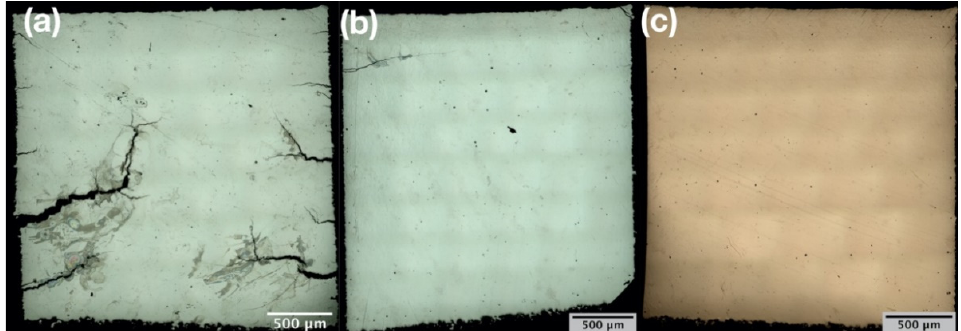
Figure 3. Typical OM images of the polished samples fabricated from the Ti 2 AlNb-CYB powder showing ( a ) severe cracking in case of 300 °C, ( b ) small occasional cracks in case of 700 °C, and ( c ) no cracking in case of 850 °C preheating temperature.